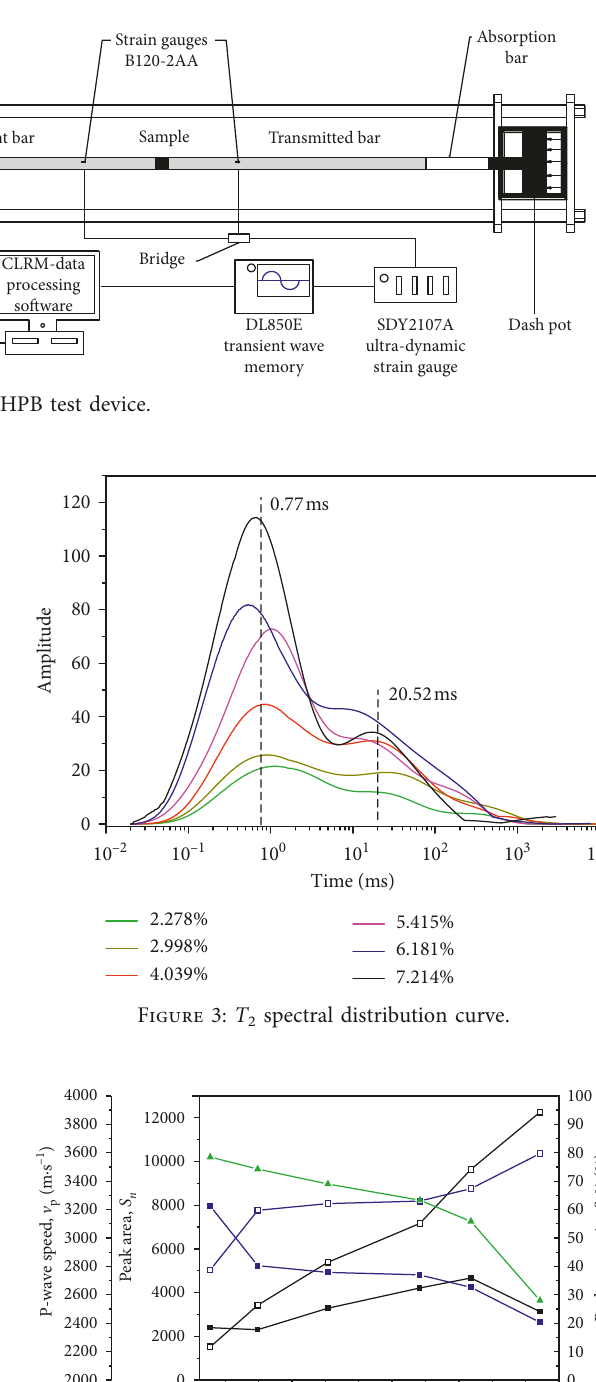
v p and S n , p , and S n %.